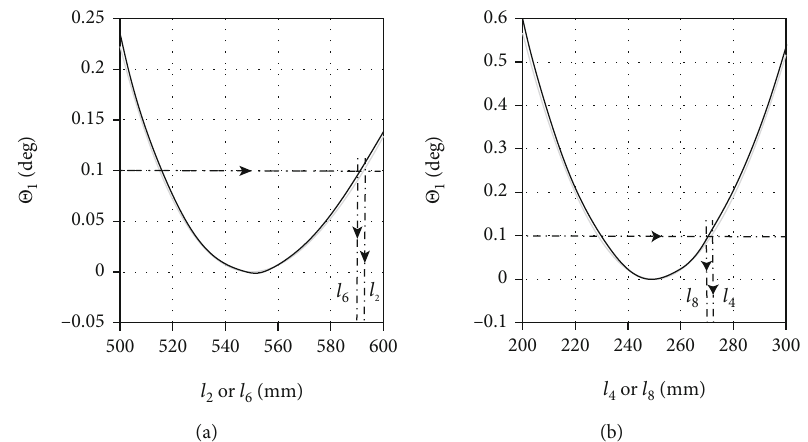
Figure 16: Curves describing the e ff ects of link lengths on the second singular point.